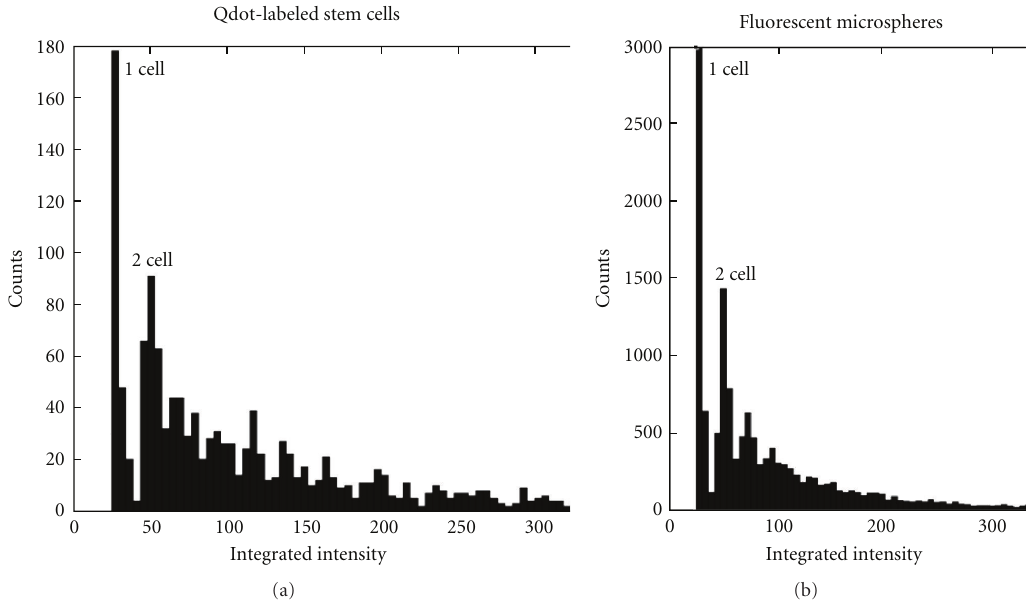
Figure 2: Histograms of the integrated intensity of clusters of fluorescently labeled cells and microspheres. Since cells/microspheres were dispersed, the largest peaks correspond to single cells/microspheres. Note that the next large peak occurs at 2 times the integrated intensity of the first peak, indicating two cells in a cluster. We use values in the “1 cell” peak to estimate parameters for subsequent processing of